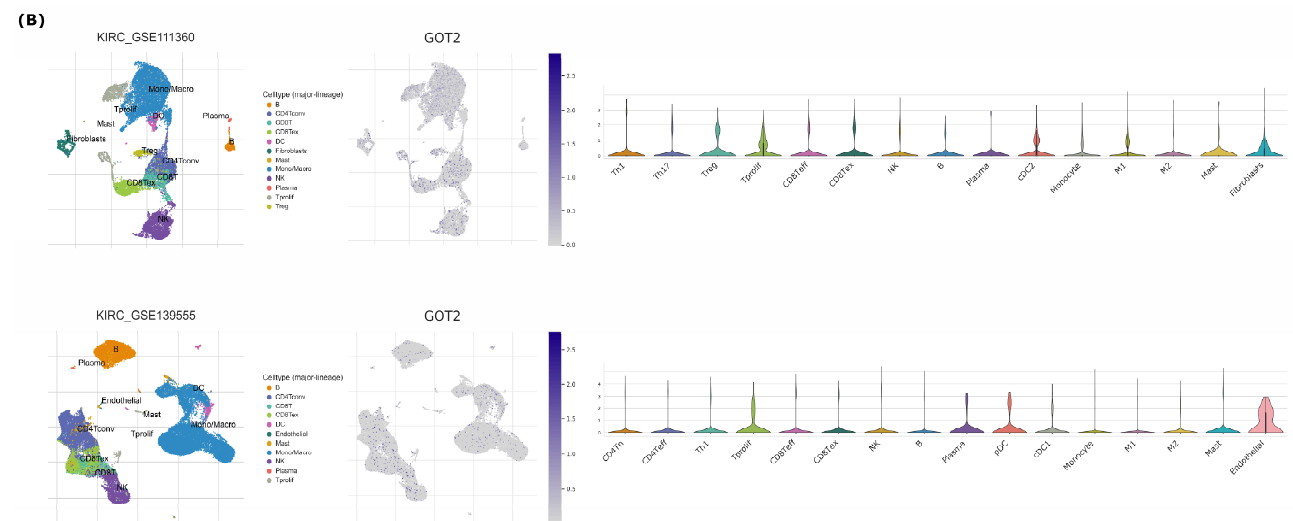
Figure 9. Expression of GOT2 in scRNA-seq landscapes. ( A ) Heatmap of GOT2 expression displayed heterogeneity in different clusters of cells in KIRC_GSE111360 [55] and KIRC_GSE139555 datasets [56]. ( B ) Expression of GOT2 in GSE111360 (upper panel) and in GSE139555 (lower panel) datasets after Uniform Manifold Approximation and Projection (UMAP) processing. Violin diagrams depict the GOT2 expression in different immune cells across each dataset analyzed.